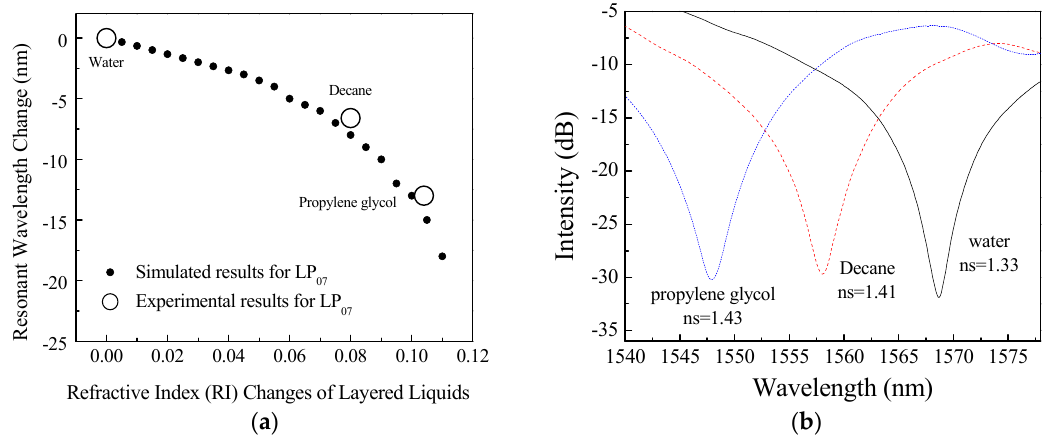
Figure 6. ( a ) Experimental and simulated resonant wavelength changes of LP 07 in responding to changes in liquid interfaces; ( b ) Spectrum changes with liquid interface changes.